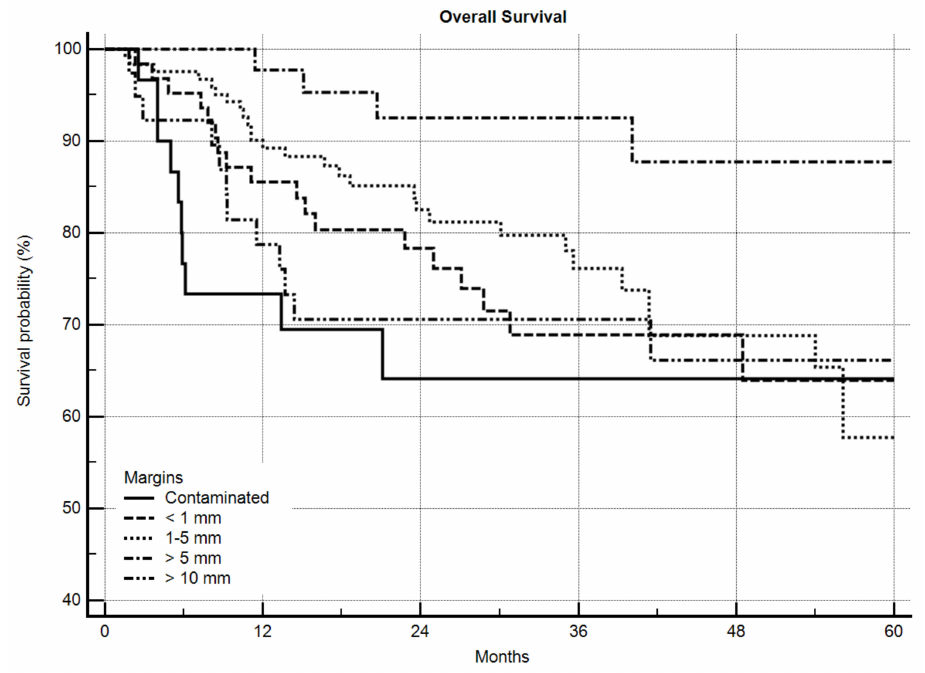
Figure 5. Overall survival by margin in detail, n = 305, p =